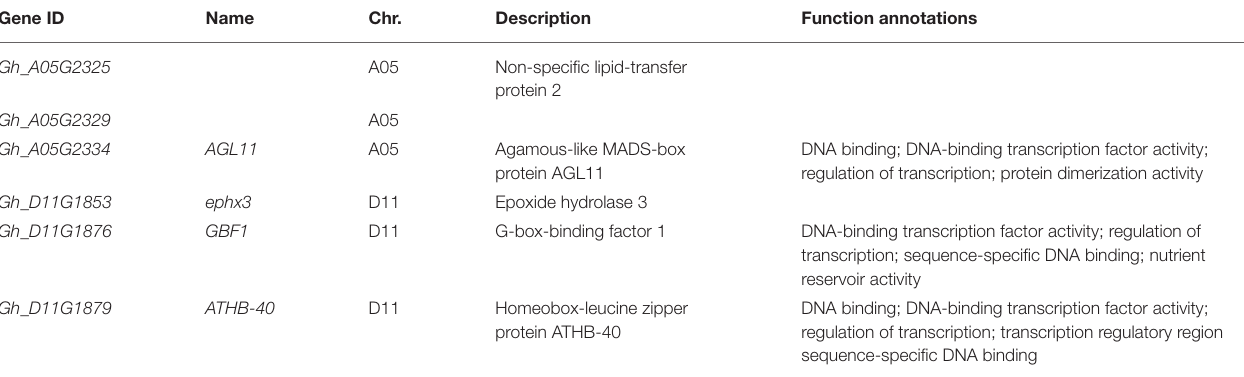
TABLE 4 | The biological function annotations of the six putative candidate genes for five fiber-quality related traits. Gene